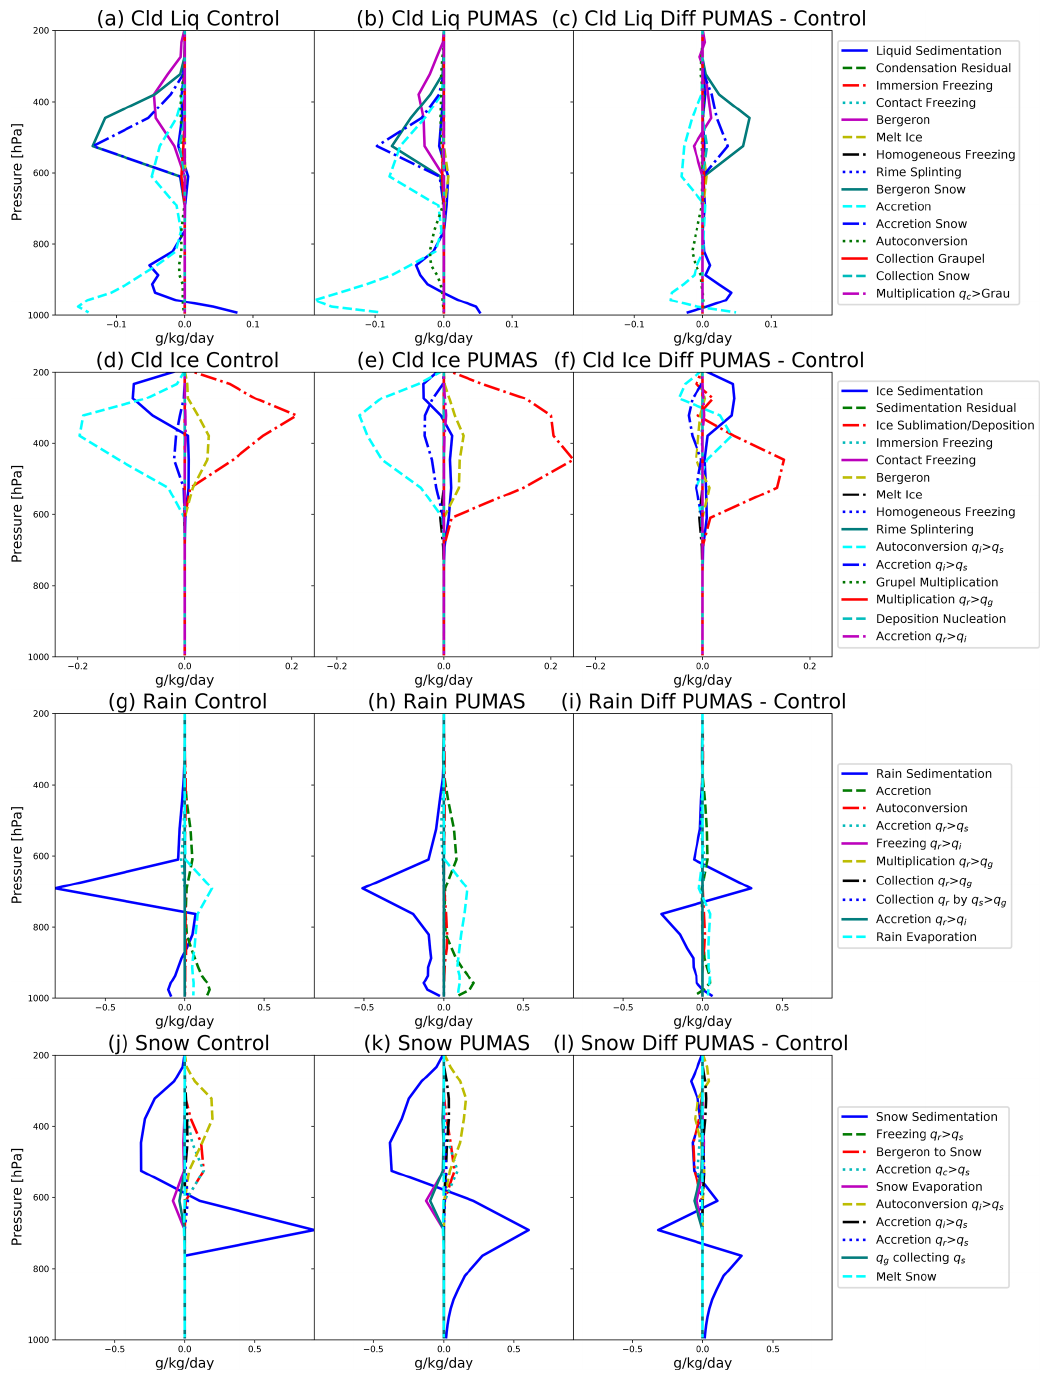
Figure 3. Mass-mixing-ratio process rate profiles from SCAM simulations. The left column (a, d, g, j) is the MG3 control simulation, the center column (b, e, h, k) is the PUMAS code (Table 1; change nos. 1–7), and the right column (c, f, i, l) is the difference. The top row (a–c) shows results for cloud liquid, cloud ice (d–f) , rain (g–i) , and snow (j–l) ,